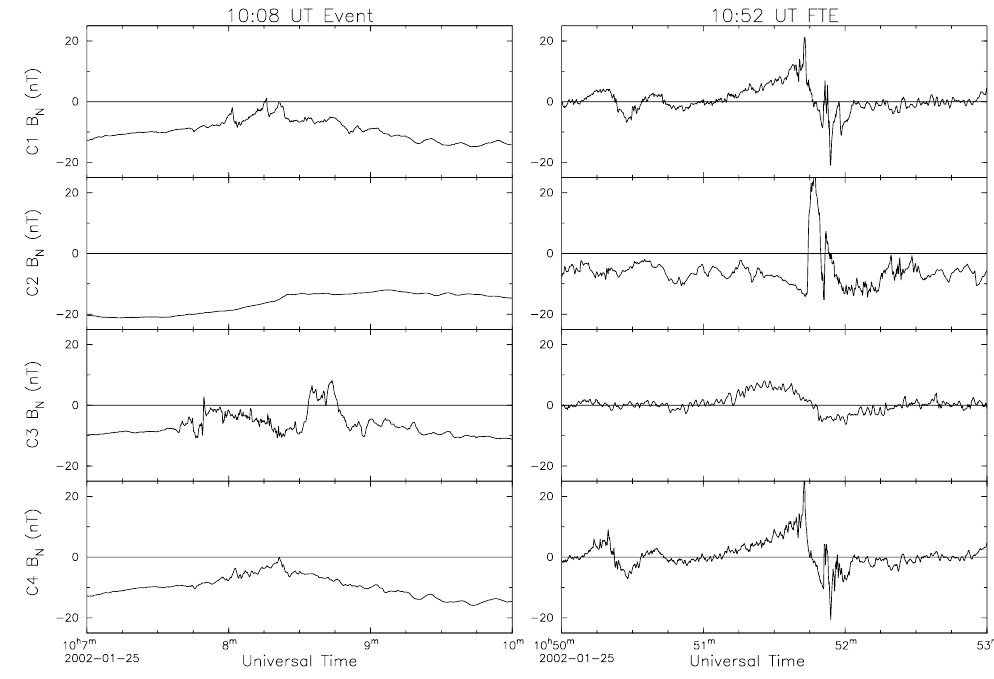
Fig. 9. The B N signatures observed by the four Cluster spacecraft at 10:08 and 10:52 UT.